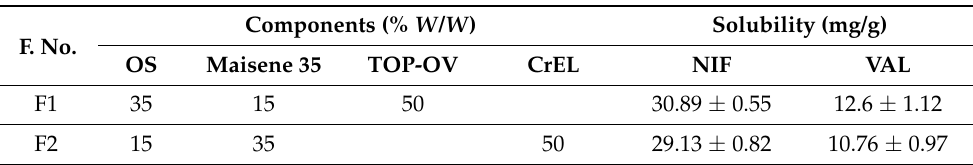
Table 1. Solubility of the optimized SNEDDS formulations of NIF and VAL in olive squalene oil (OS), Nikkol (Trioleyl Phosphate) (TOP-OV) and Cremophore EL (CrEL). F.